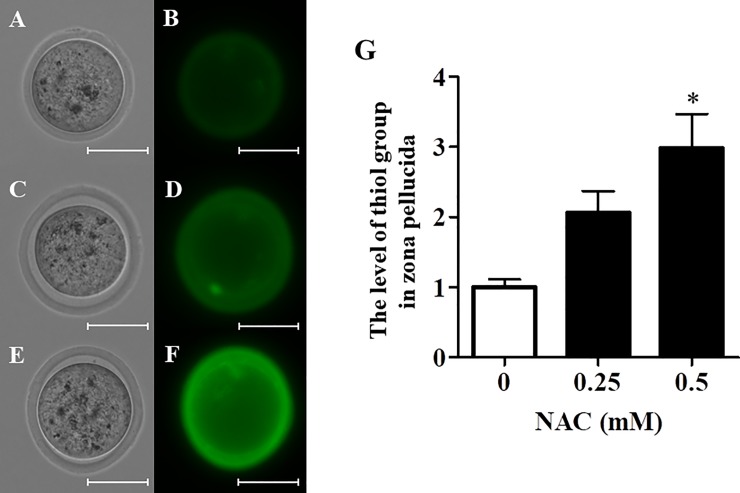
Effect of NAC on thiol levels in vitrified–warmed oocytes.The level of thiol group of vitrified warmed oocytes treated with or without NAC was measured by fluorescence intensity of the thiol-selective fluorescent compound AFM (31–34 oocytes/experiment). The oocytes were shown (A: 0 mM, C: 0.25 mM, E: 0.5 mM: bright field, B: 0 mM, D: 0.25 mM, F: 0.5 mM: fluorescence, scale bar shows 50 μm). G) Thiol levels in the ZP were calculated as follows: Fluorescence intensity of each group / Fluorescence intensity of 0 mM NAC) × 100. Results are expressed as mean ± SD (n = 4). *P < 0.05 compared with control (0 mM NAC).